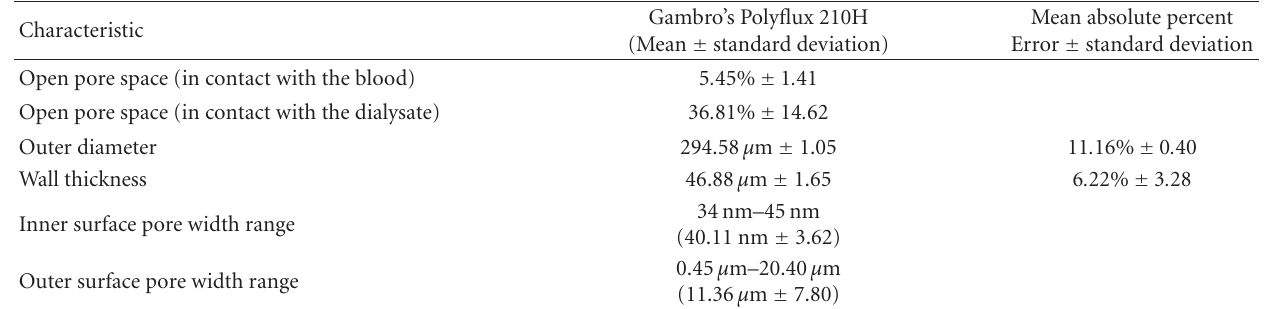
Table 1: Characterization summary of Polyflux 210H and the results are presented as mean ± standard deviation.